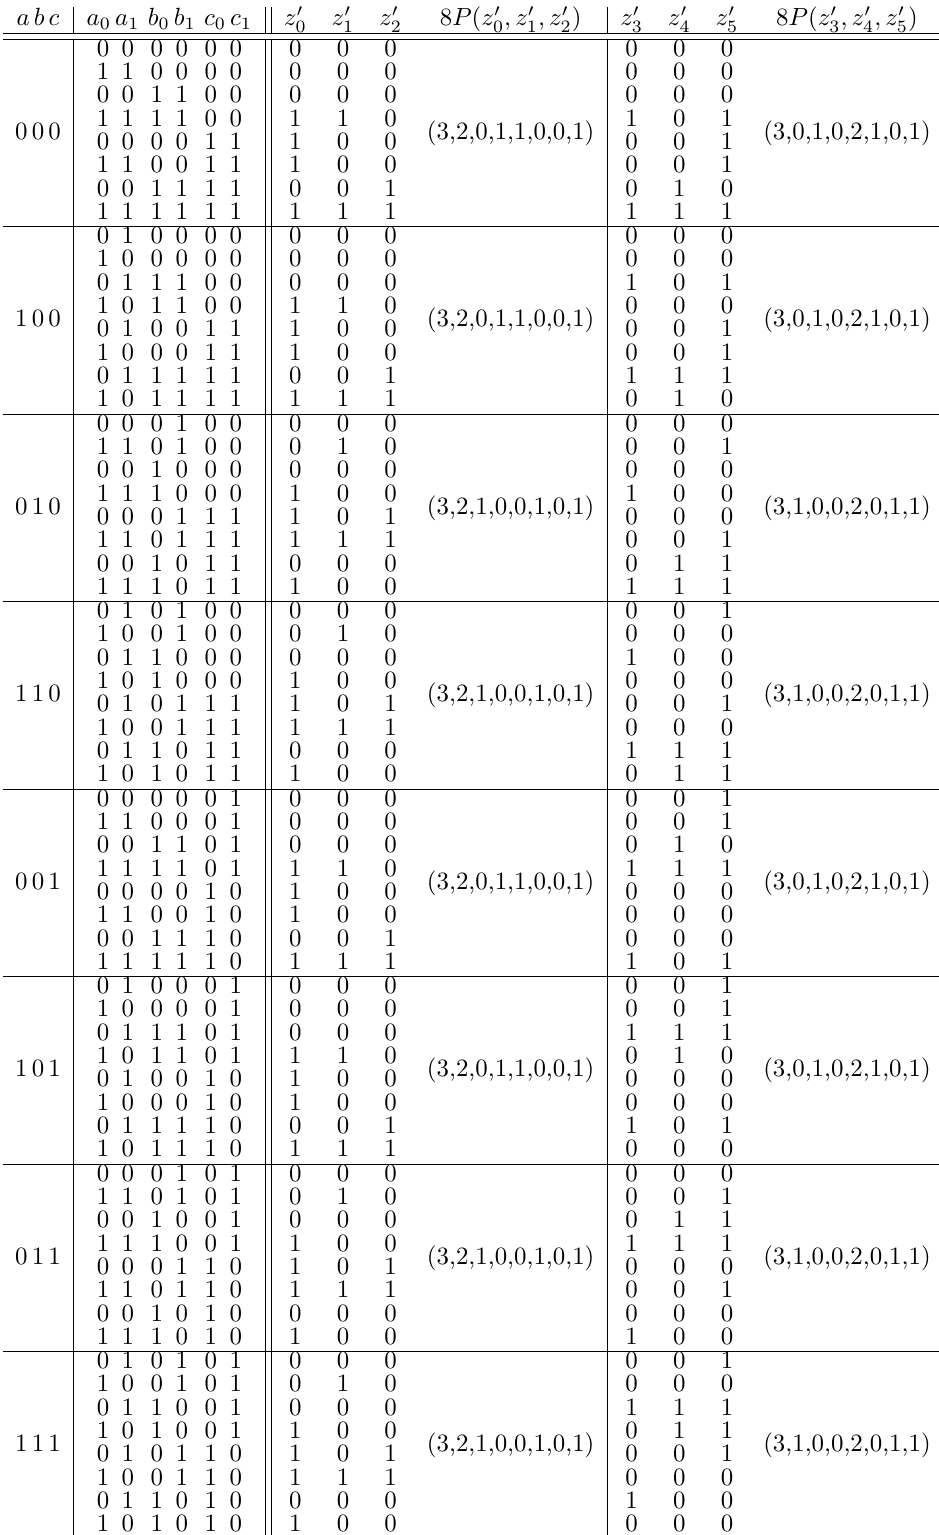
of [RBN + 15] in Equation (3). 300